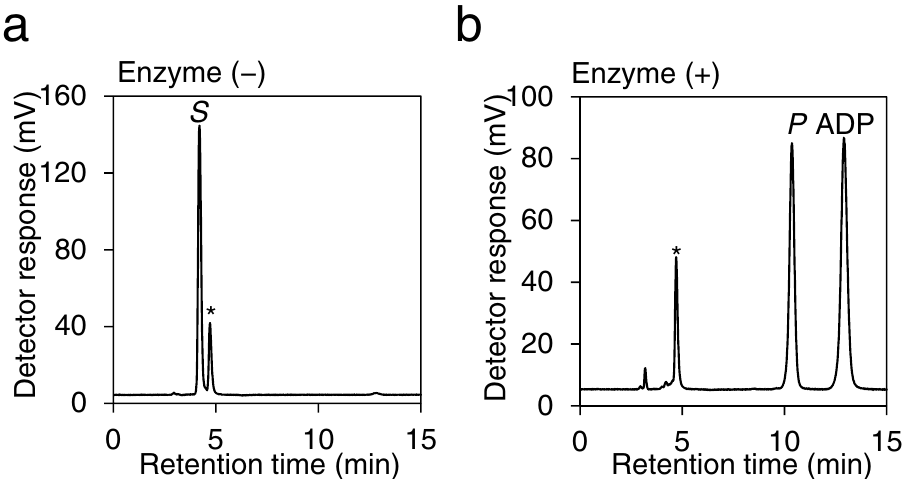
Figure 3. HPLC analysis of GlcNAc phosphorylation products. The reaction mixture in the absence ( a ) or presence ( b ) of the enzyme, comprising 10 mM GlcNAc, 10 mM ATP, and 10 mM MgCl 2 , was carried out in 50 mM Tris–HCl (pH 8.0) at 30 °C for 3 h and analyzed by HPLC. The retention time of each peak detected at UV = 205 nm was matched to that of the standard compounds: S , GlcNAc (4.2 min); P , GlcNAc-6-P (10.4 min); ADP (12.4 min); *, Tris (4.7 min).